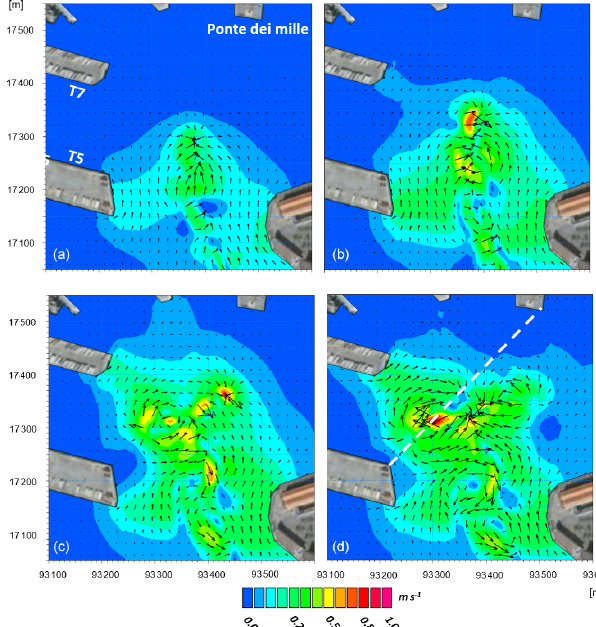
Figure 8. Results of the hydrodynamic model at the depth of the propeller’s axis. Each panel refers to a time interval of approxi- mately 100s from the previous panel. The temporal order of the panels is as follows: (a) , (b) , (c) , and (d) . The images refer to dock- ing maneuvers of the Ro-Ro vessel representative of dock T7. Land background from © Google Earth.